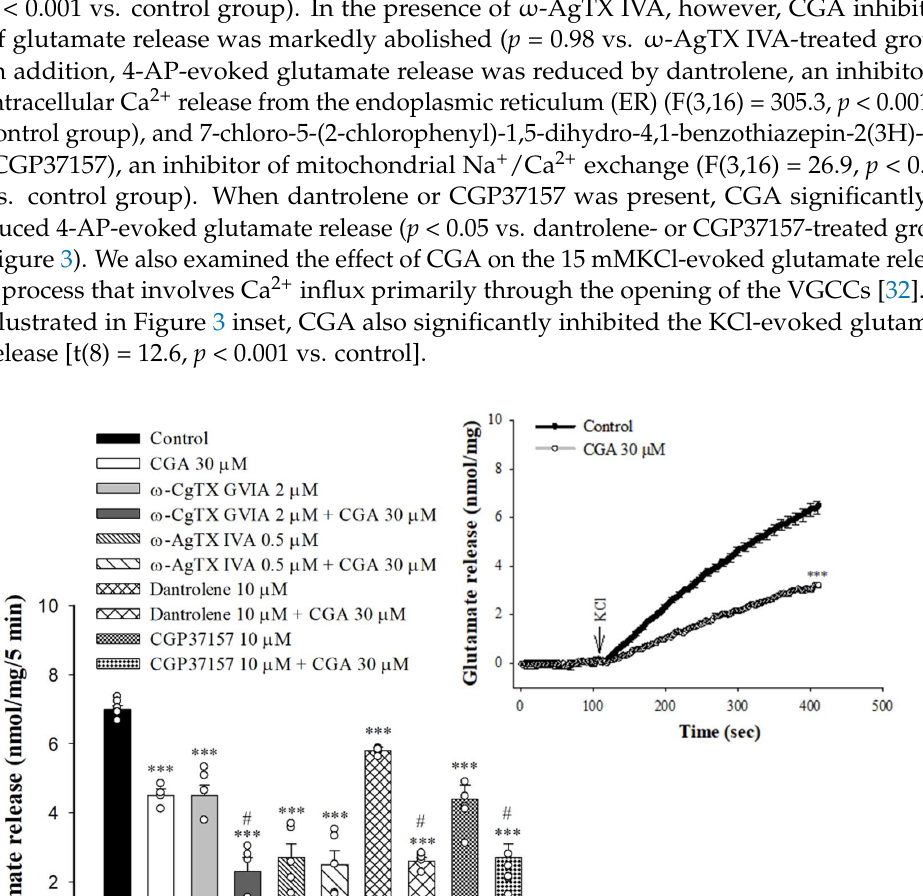
Figure 4. Molecular docking of CGA to P/Q-type Ca 2+ channel protein. The interaction between CGA with the binding site of molecular structure of P/Q-type Ca 2+ channel protein (PDB ID 3BXK) was predicted by the Discovery Studio 4.1 software. Hydrogen-bonding interactions (green lines) of pro- tein–ligand as shown.